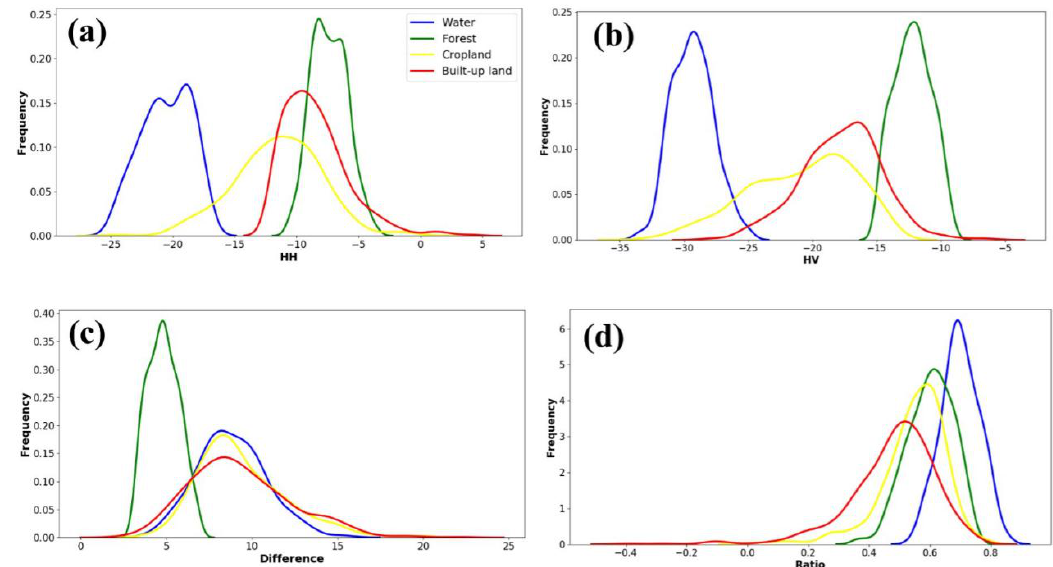
Figure 3. The backscatter signatures of different land covers in four images. ( a ) Horizontal transmission and reception (HH) polarization, ( b ) horizontal transmission and vertical reception (HV) polarization, ( c ) Difference image (HH-HV), and ( d ) Ratio image (HH/HV).